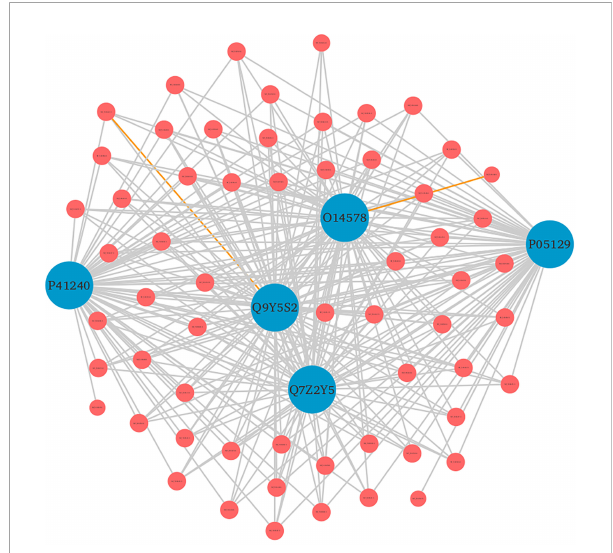
FIGURE 7 Top 5 human protein hubs based on their degree. The hub protein “ P05129 ” was found to be critically involved in various immune responses. Blue nodes represent host proteins, and red nodes are pathogen proteins. Orange edges depict the interactions from interolog-based approach, while grey edges belong to domain- based